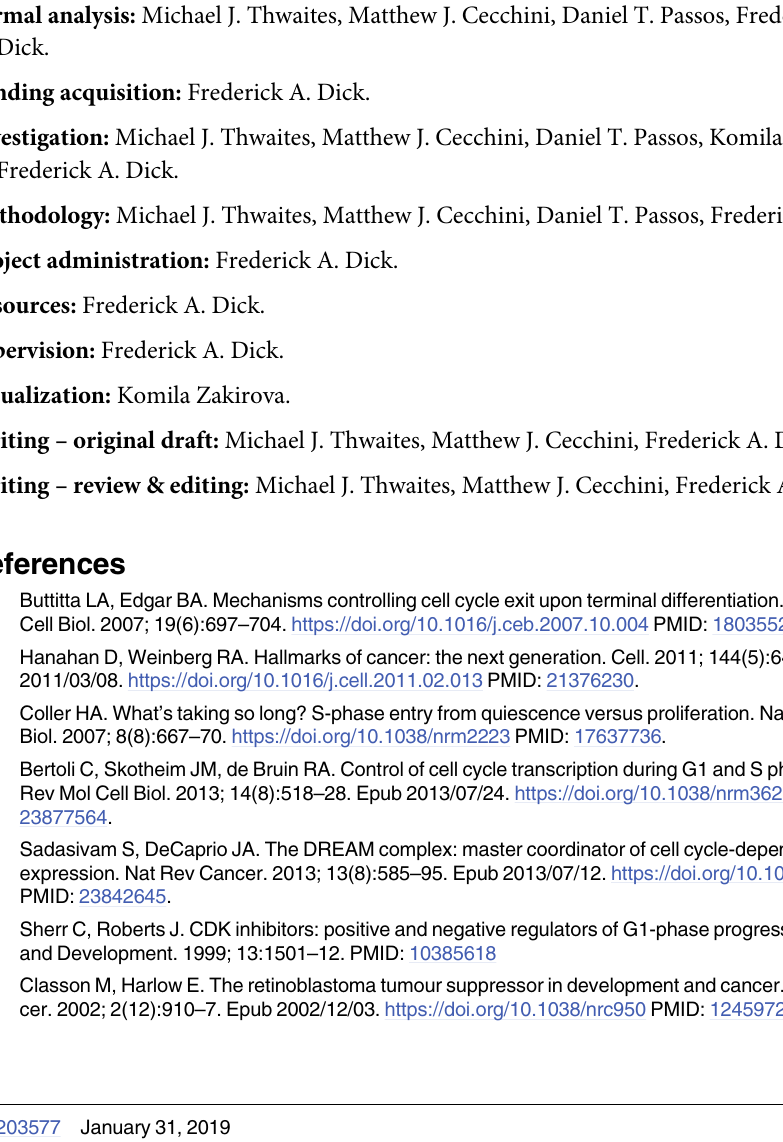
S1 File. Raw data used for generating graphs. All data used to formulate quantitative results and conclusions in this manuscript is available in this